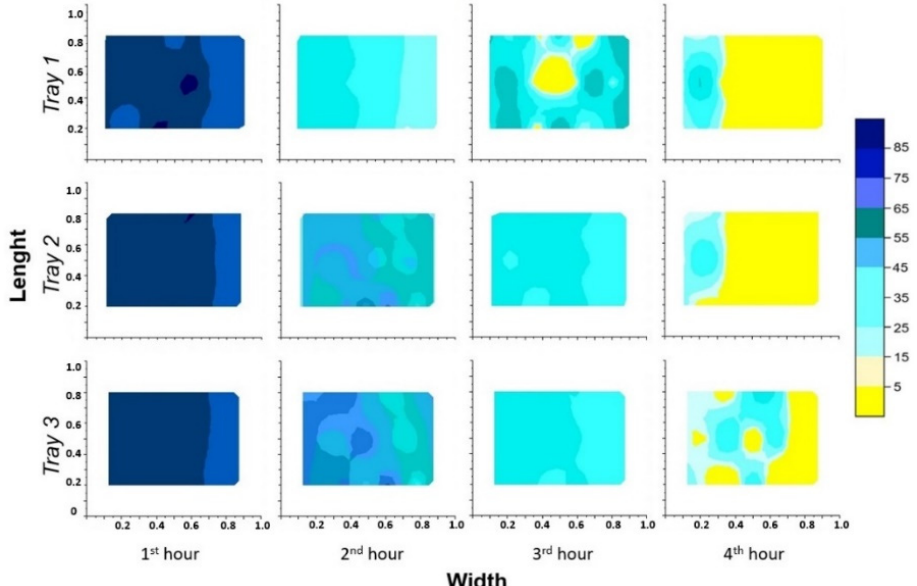
Figure 6. Drying dynamics inside the chamber of Prototype 2 (1–7 h): Tray 1—top, Tray 2—middle, Tray 3—bottom; the scale refers to percentage of weight remaining.